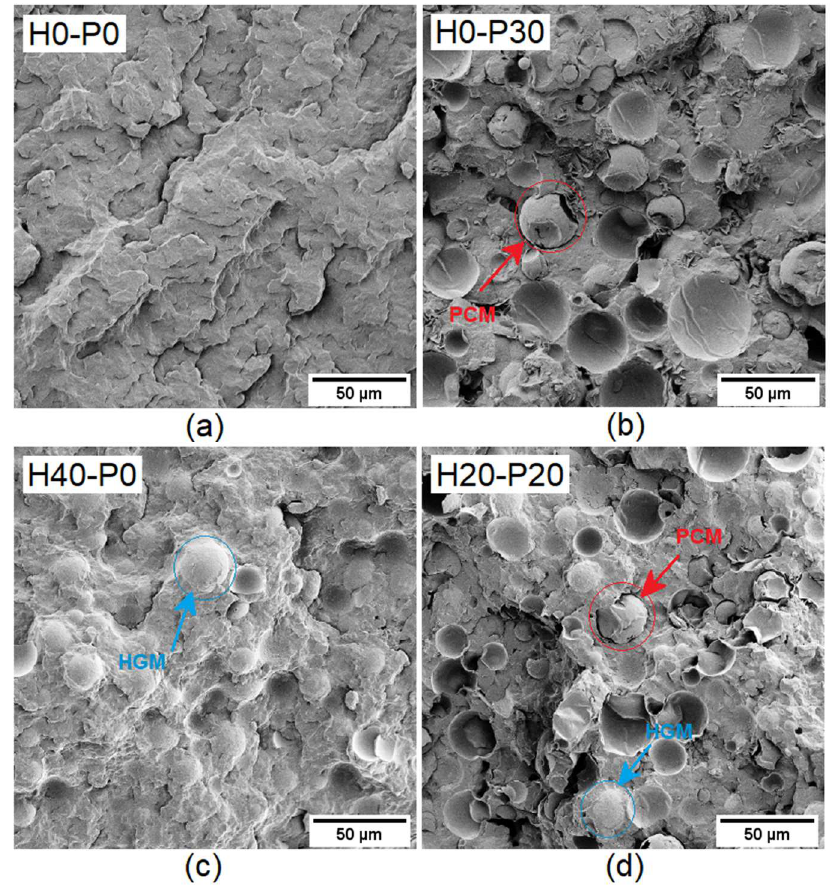
Figure 5. SEM micrographs of the cryo-fractured surfaces of four selected compositions. ( a ) H0-P0, ( b ) H0-P30, ( c ) H40-P0, and ( d ) H20-P20.